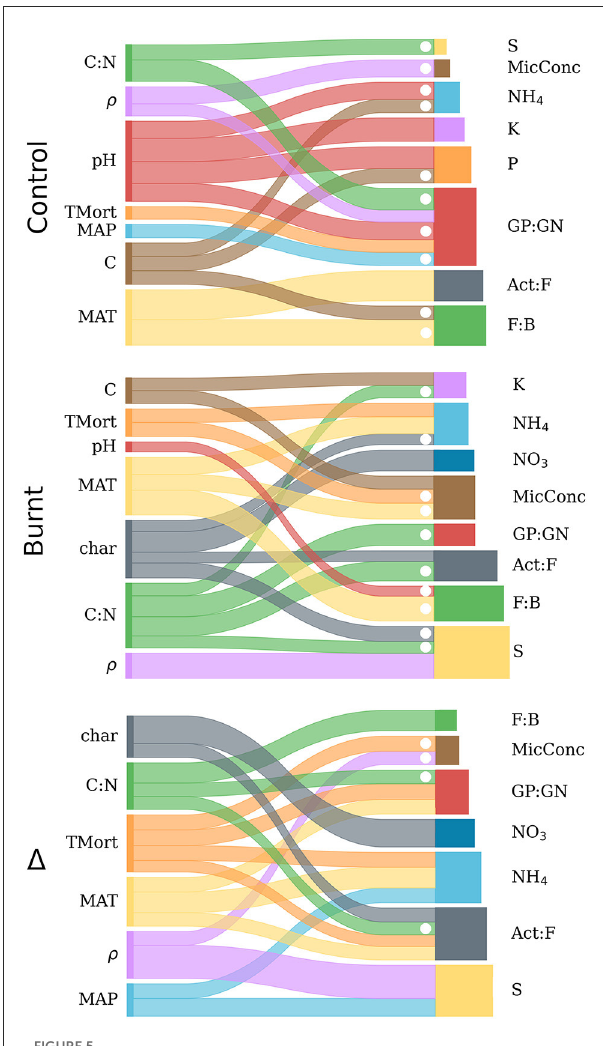
FIGURE5 Sankey diagrams representing the backwards step-wise model selection results from control, burnt and 1 variable distributions. For each of the three graphs, explanatory variables are listed on the left and connected by ribbons to the dependent variables they predict (right) . Ribbon width is scaled to the magnitude of the standardized regression coefficient from its corresponding independent variable (within each graph, but not across graphs), and dotted when this value was negative. The bars on the right sides of the graphs are scaled horizontally to the R 2 values derived from multiple regression for each independent variable and are proportional across all graphs. Numerical results for the diagrammed regressions are found in Table 4.